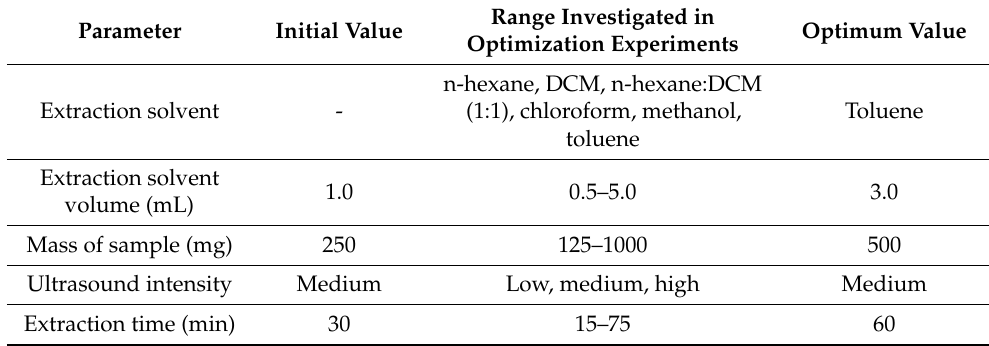
Table 3. Initial, range, and optimum extraction